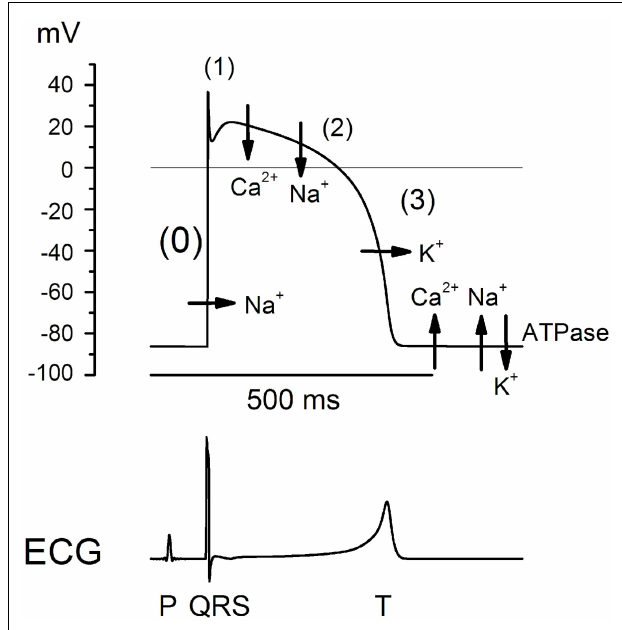
FIGURE 2 | Development of action potential in the His–Purkinje system: passive ion movements (phase 0, 1, 2, and 3), and then active ionic movements (ATPase-dependent during diastole). Lower trace: correlation with ECG recording.